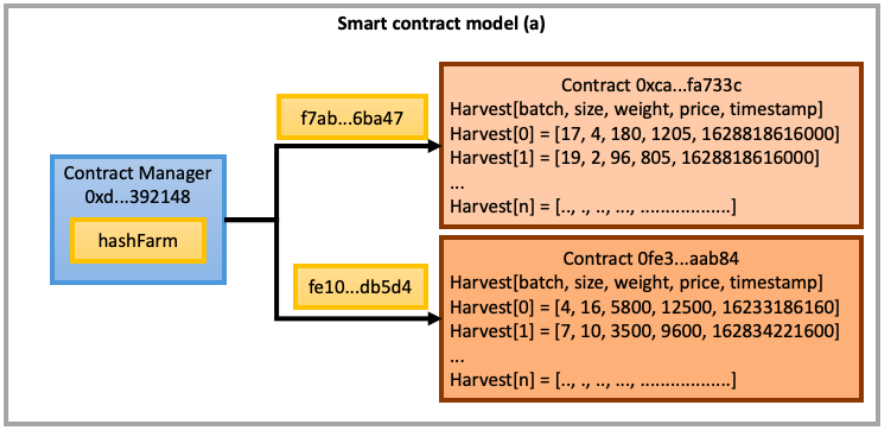
Figure 5. One smart contract for each farm